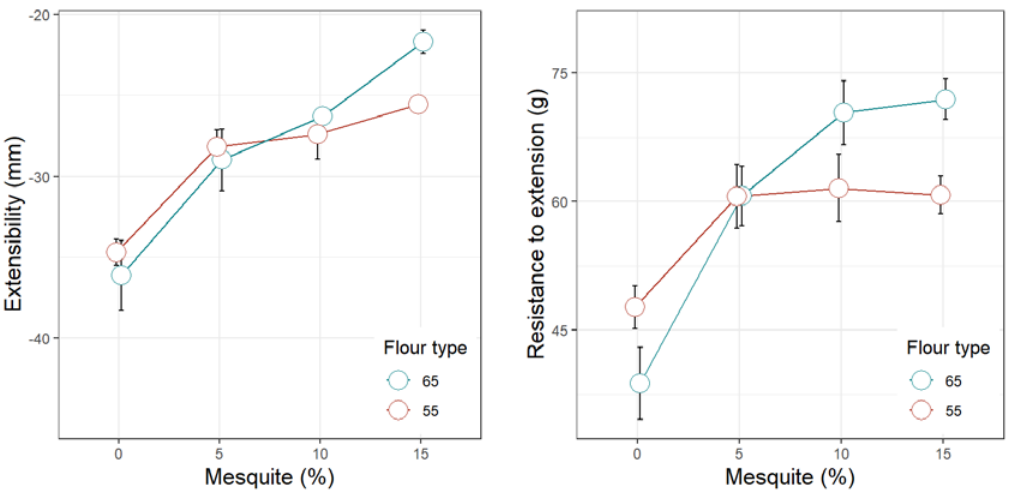
Figure 2. Extensibility properties of dough made of wheat flour type 65 or 55 partially replaced with mesquite pod flour.